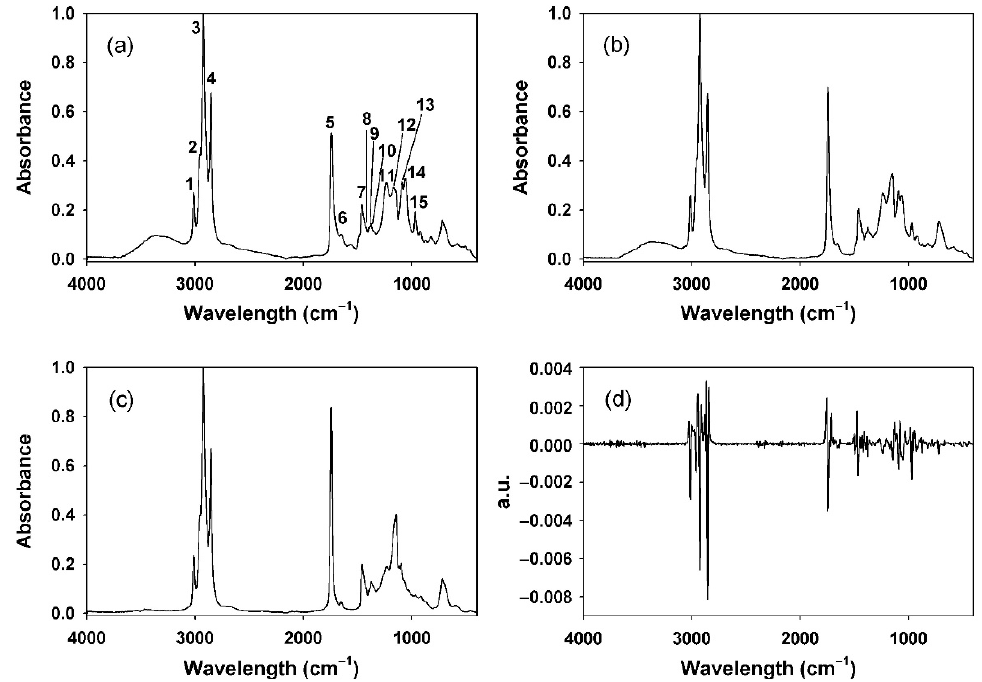
Figure 1. FT-IR absorption spectra of ( a ) USP reference standard krill oil sample, ( b ) fish oil, and ( c ) mixture sample of krill oil raw material and fish oil (50/50, w/w %). ( d ) Second-derivative FT-IR ( c ) mixture sample of krill oil raw material and fish oil (50/50, w / w %). ( d ) Second-derivative FT-IR spectrum of ( c ). See Table 1 for each peak assignment. spectrum of ( c ). See Table 1 for each peak